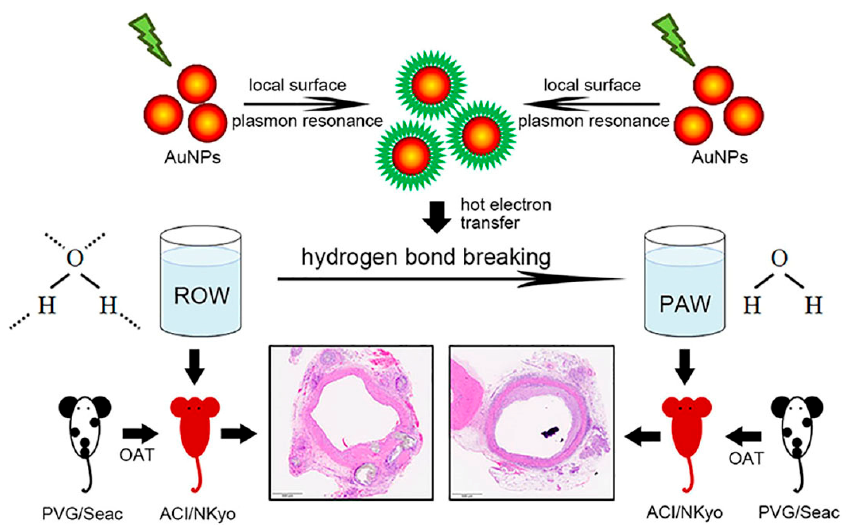
Figure 5. PAW may regulate chronic rejection-induced vasculopathy in OAT rats. Daily intake of PAW lowered the progression of vasculopathy in OAT-recipient ACI/NKyo rats by inhibiting collagen accumulation, proliferation of smooth muscle cells and fibroblasts, and T lymphocyte infiltration in the vessel wall. Moreover, the results showed reduced T and B lymphocytes, plasma cells, and macrophage activation in the spleens of the OAT-recipient ACI/NKyo rats that were administered PAW. Therefore, this study highlights the therapeutic roles of PAW and provides a more effective drug therapeutic route in